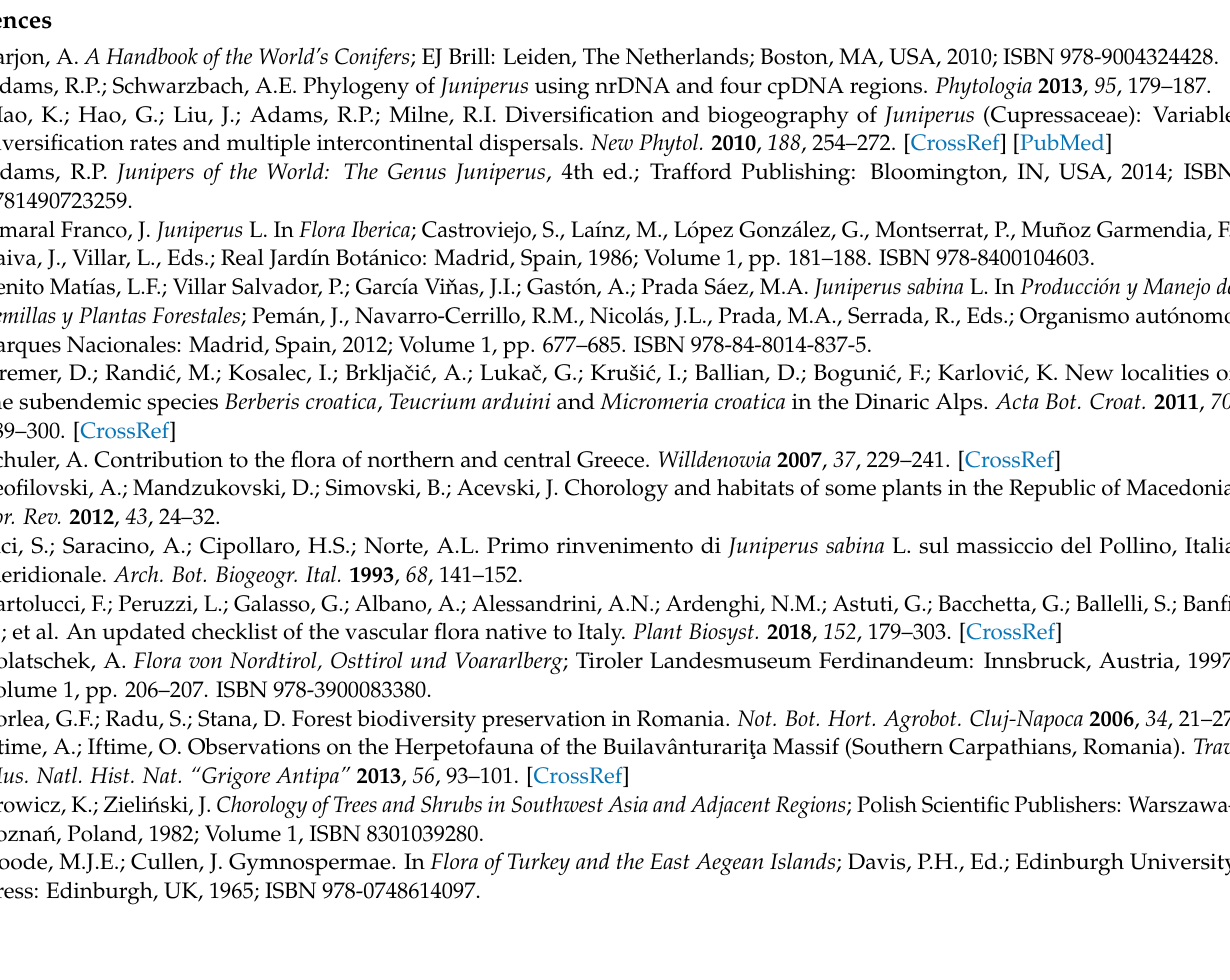
populations (acronyms—Table 1), Table S3: Results of two-factor nested mixed analysis of variance between populations and regions, for characters meeting